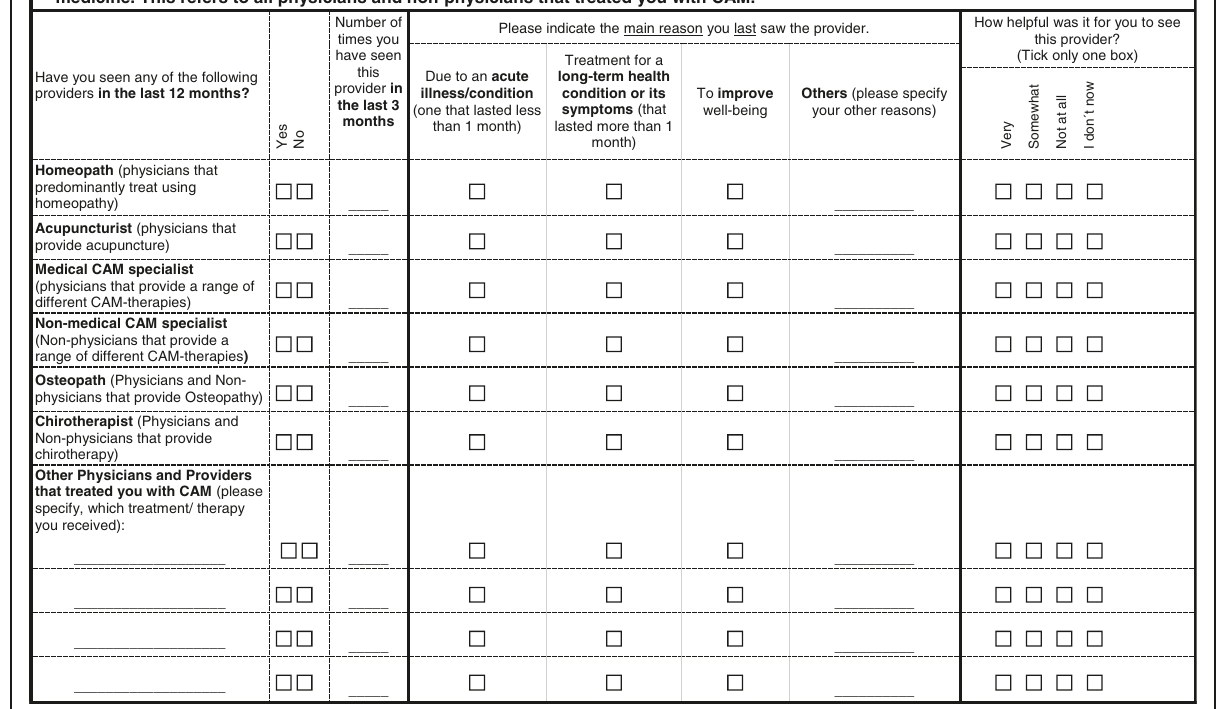
Figure 1 First page of I-CAM-G (German version, but translated to